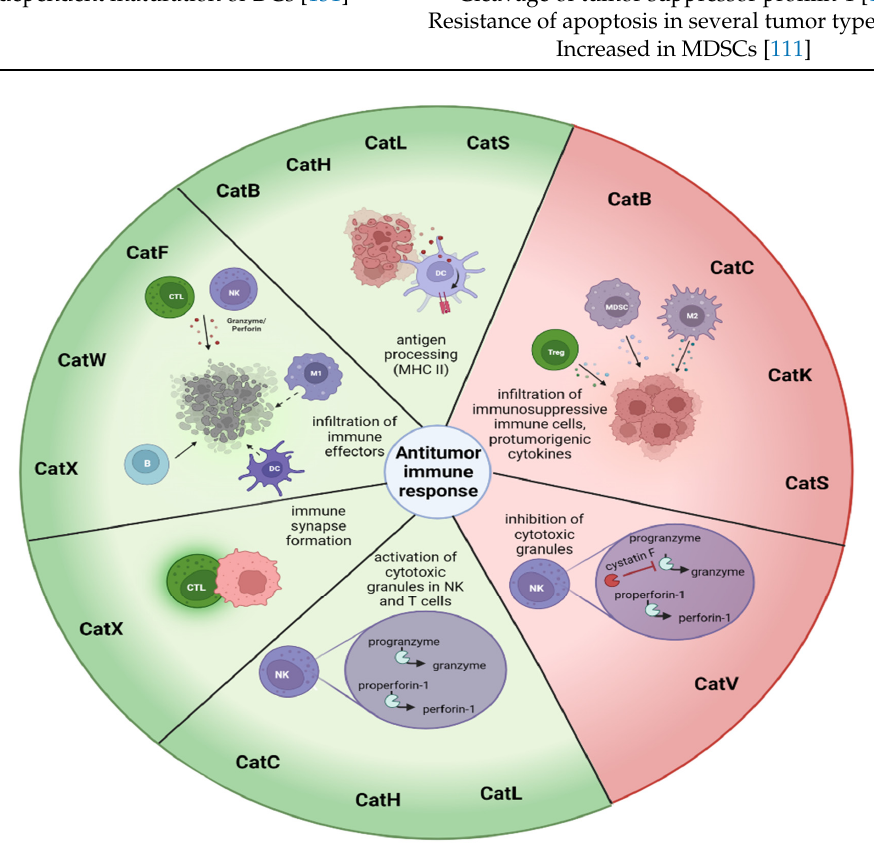
Figure 3. Cysteine cathepsin involvement in antitumor immune response. Cysteine cathepsins are involved in several beneficial as well as negative processes in antitumor immunity. On the one hand,